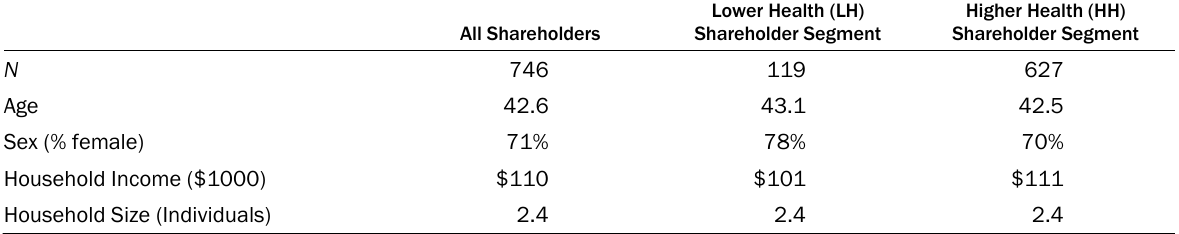
Table 2. Demographics for Survey Participants: All Shareholders and Shareholders by Self-Assessed Health All